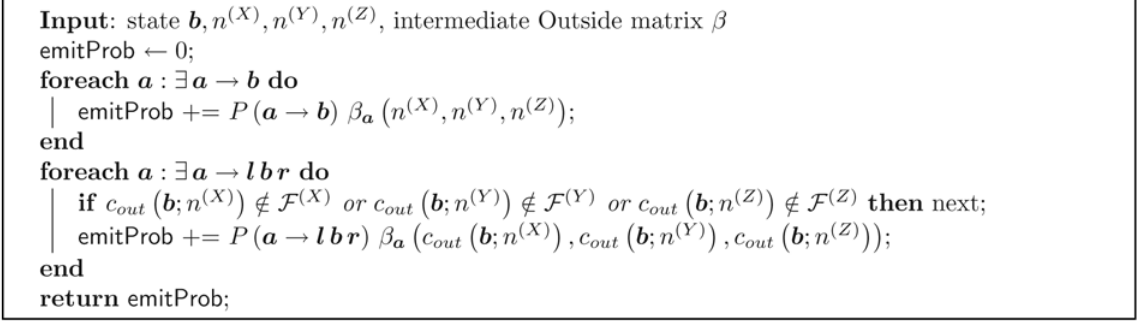
Figure 7. Algorithm 7. Subroutine calcTransEmitProb() for the Outside algorithm. a and b are ensemble states; l and r are left and right terminal emissions.